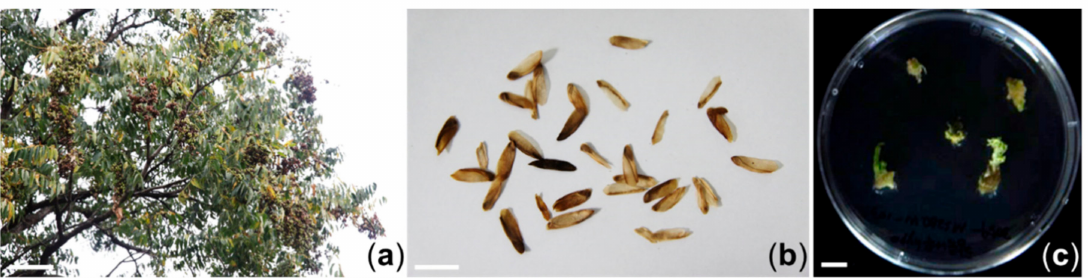
Figure 1. Establishment of an in vitro proliferation system from hypocotyl explants of T. sinensis : ( a ) Field grown plant of T. sinensis ; ( b ) Mature seeds of T. sinensis ; ( c ) In vitro grown adventitious shoots of T. sinensis . Scale bar, 1 m in ( a ) and 1 cm in ( b , c